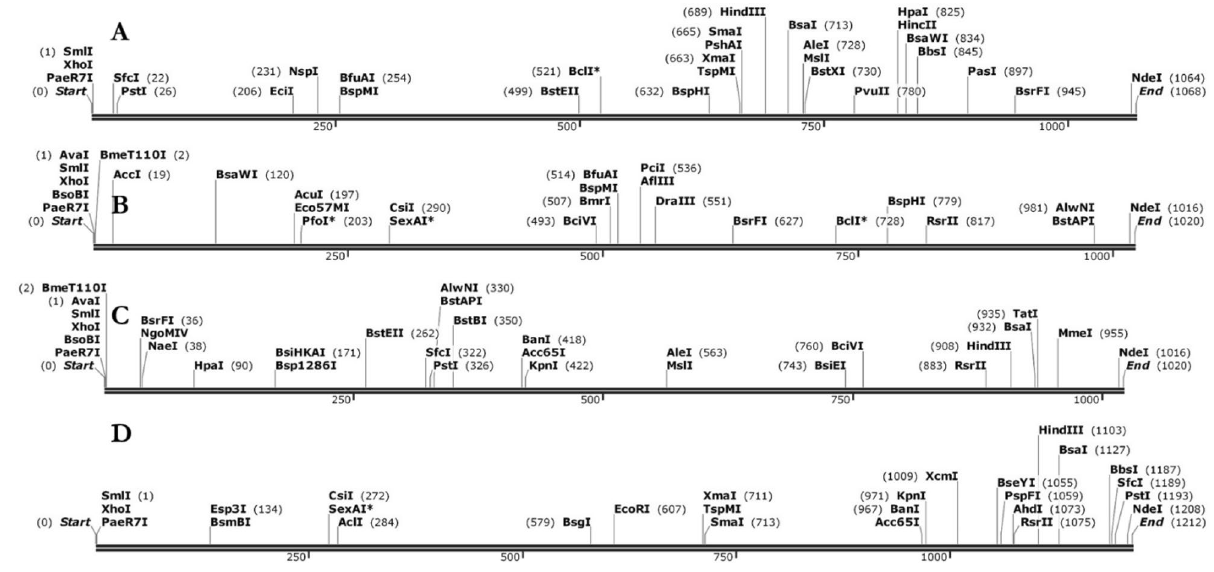
Figure 8. The linear vaccine constructs with Xho I and Nde I sites. ( A ) DV-1, ( B ) DV-2, ( C ) DV-3, and ( D ) DV-4 (SnapGene